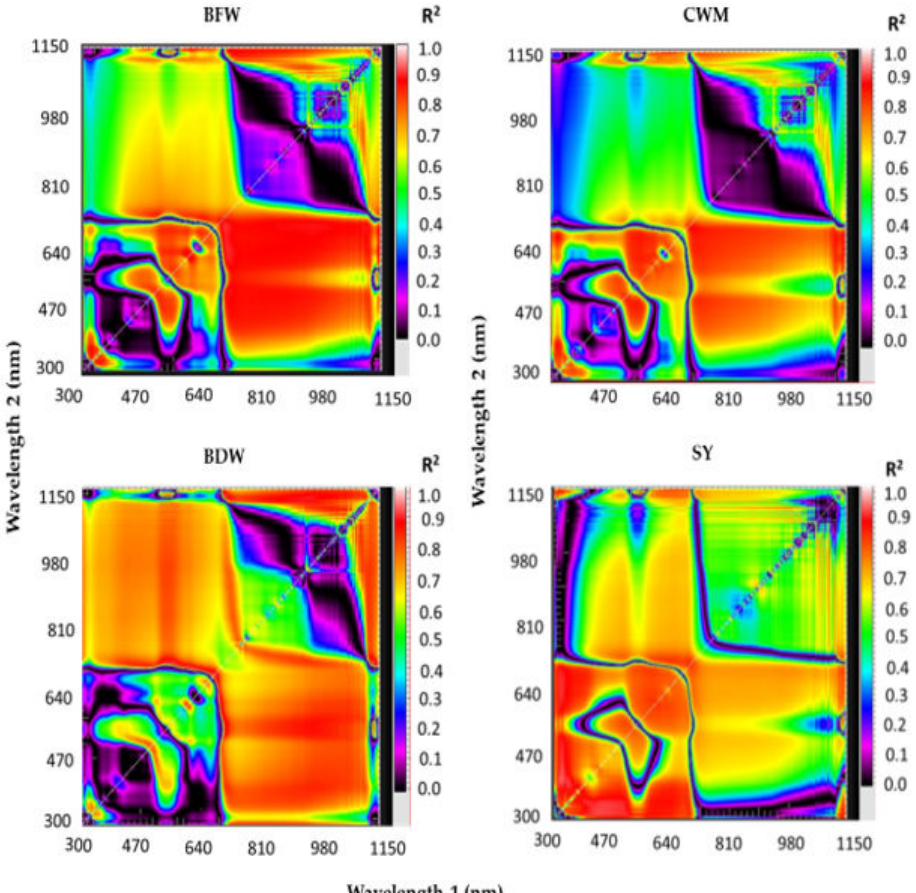
Figure2. Two-dimensionalcorrelogramsshowthecoe ffi cientsofdetermination(R 2 )fortherelationships between values of vegetative growth traits (biomass fresh weight (BFW), biomass dry weight (BDW), canopy water mass (CWM), and seed yield (SY)) and the spectral reflectance indices calculated from all possible combinations of dual wavelengths of binary in the entire spectrum range (from 302 to 1148 nm) using the pooled data of replications, irrigation regimes, and seasons at the full seed (R6) growth